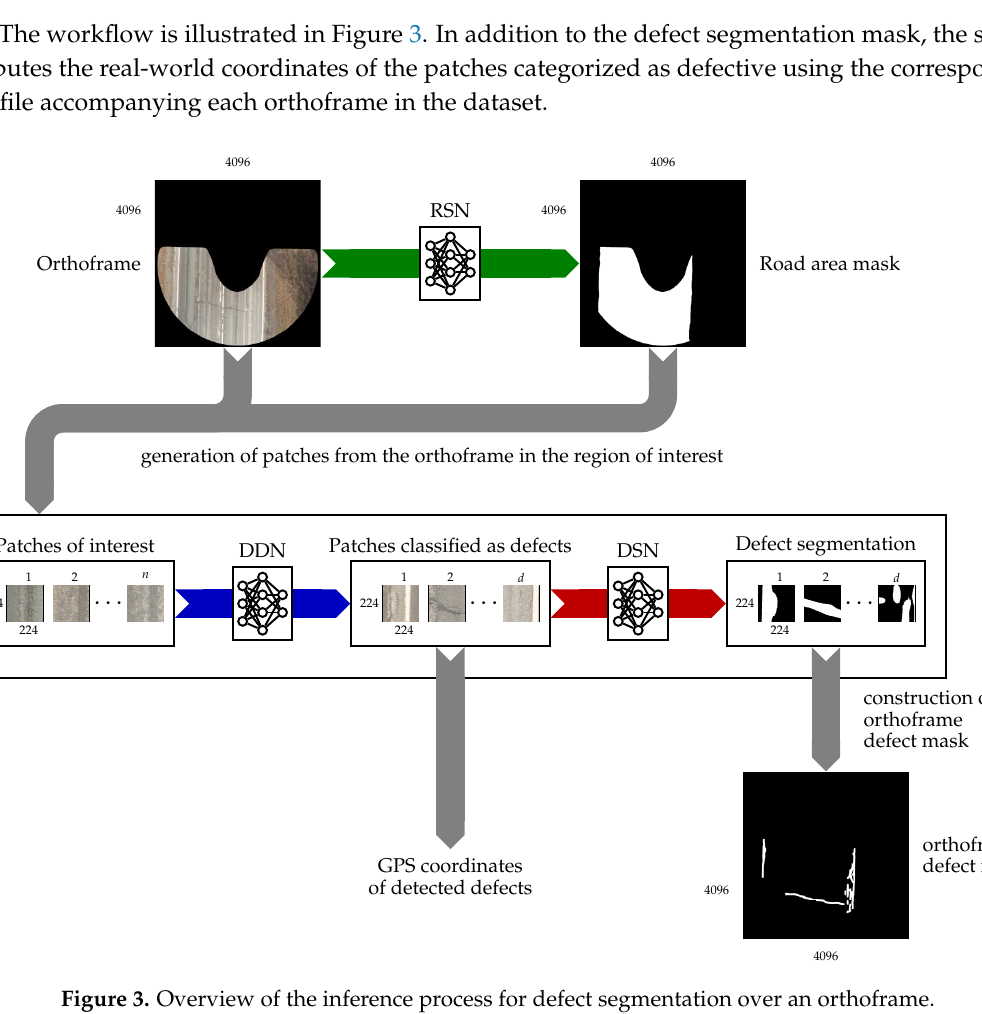
Figure 3. Overview of the inference process for defect segmentation over an